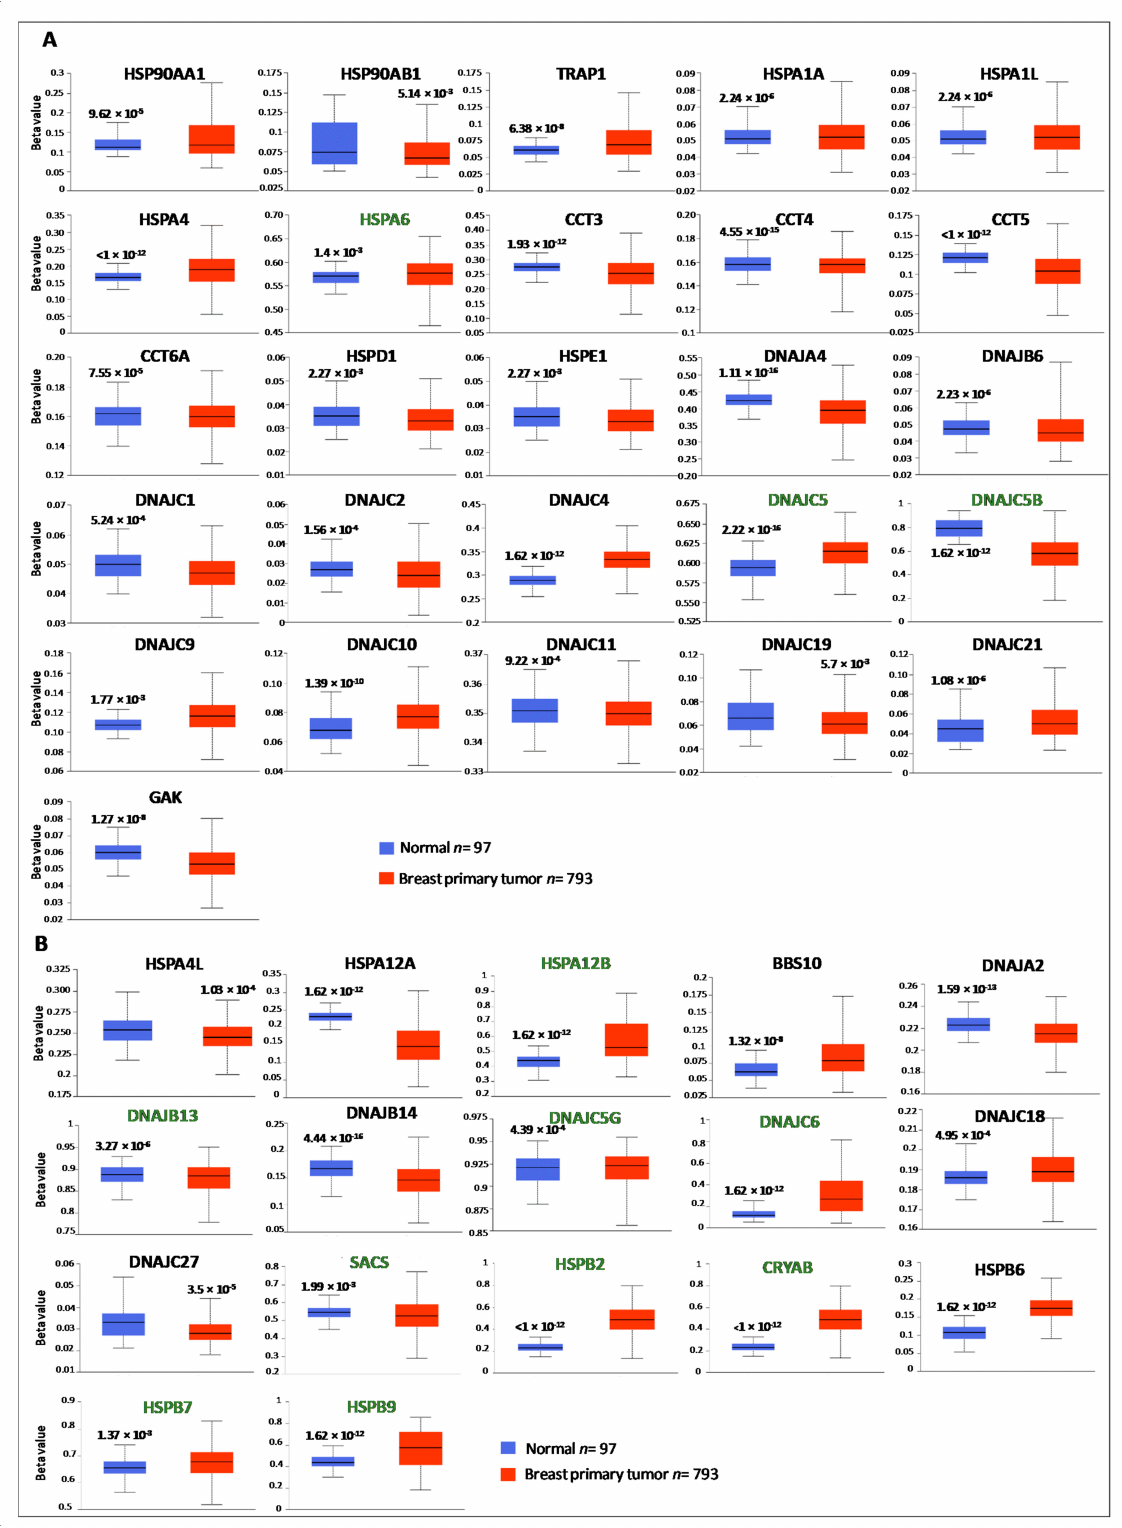
Figure 3. Analysis of promoter methylation status in HSP members differentially expressed in BC. For each HSP member the levels of promoter methylation between normal and breast cancer were retrieved from UALCAN database. Beta value cut-off indicates hyper-methylation [beta value: 0.7–0.5] or hypo-methylation [beta-value: 0.3–0.25]. HSP members with hyper-methylated promoters are marked in green; HSP members with hypo-methylated promoters are marked in black. Box plots showing the promoter methylation status between normal and breast primary tumors in HSPs up-regulated ( A ) and down-regulated in BC ( B ). p < 0.01 was considered